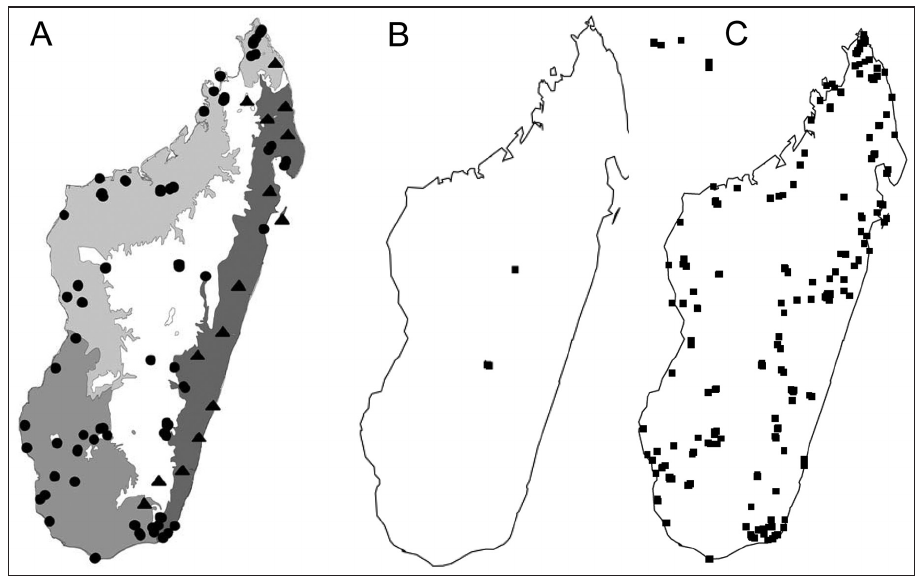
Figure 3. A Localities for field collecting B Carebara records in 2012 C Distribution of Carebara in the Malagasy region in